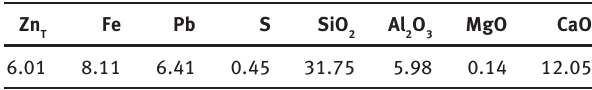
Table 1: The chemical composition of low grade oxide zinc ore (mass fraction, %).